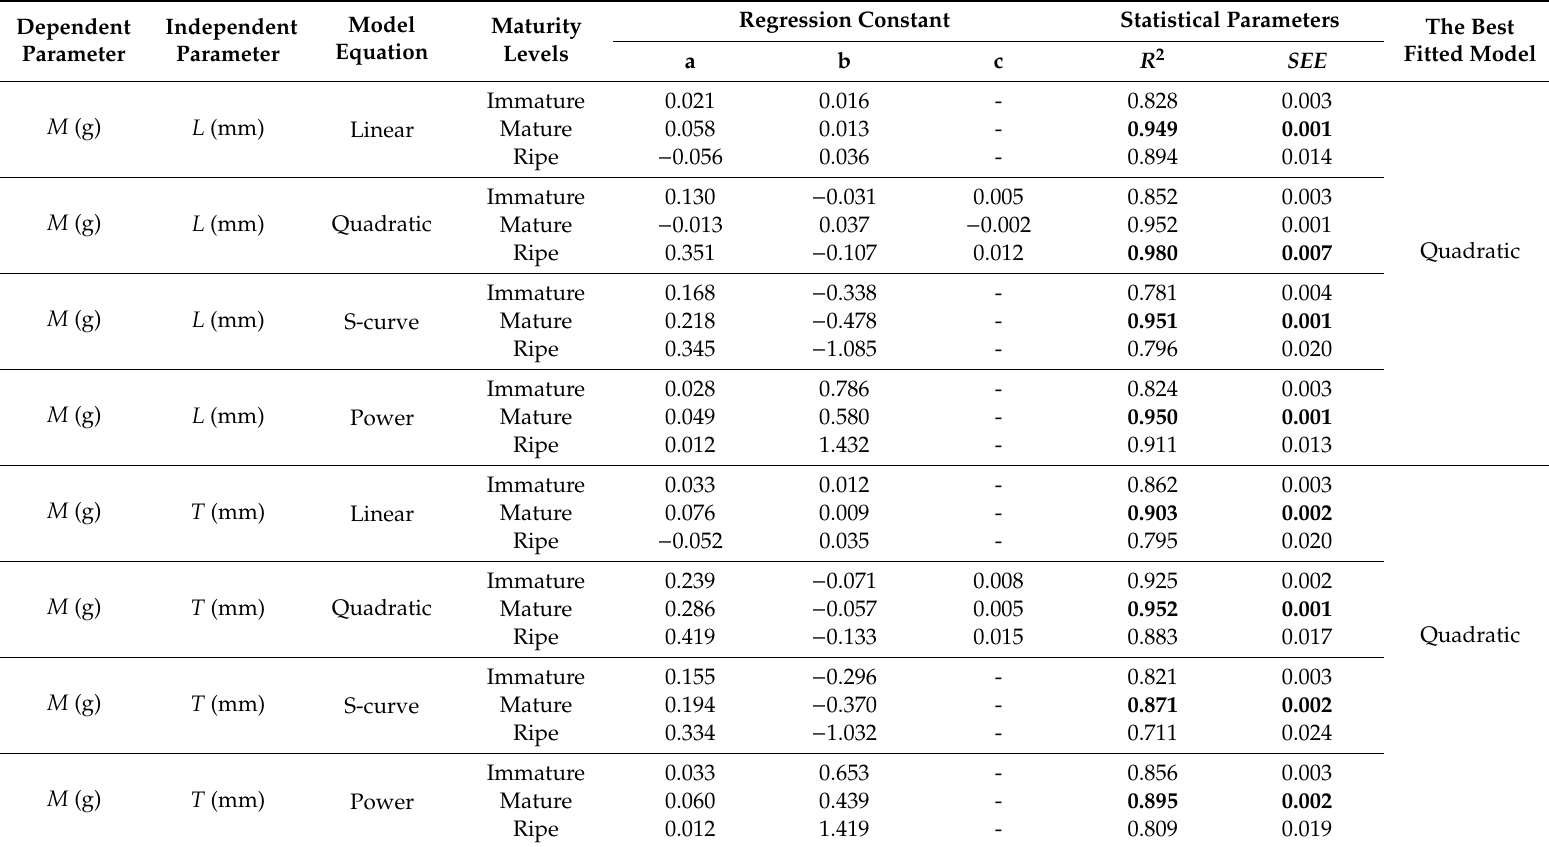
Table 2. Mass models of pepper berries based on